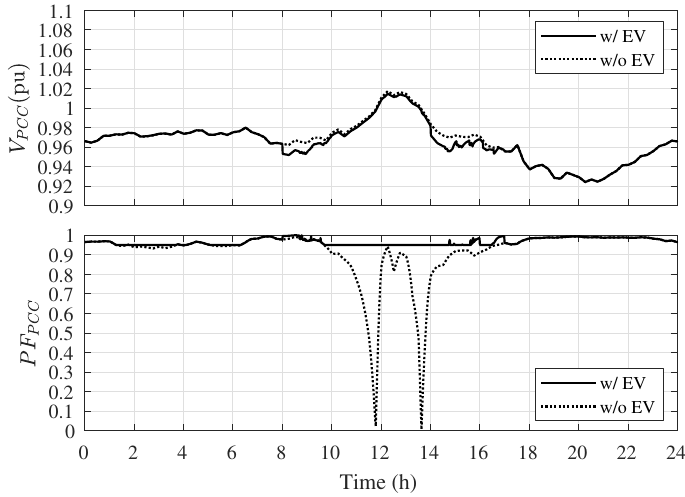
Figure 14. Power factor and voltage at the PCC of the proposed microgrid for scenario 3. The SOC of each vehicle with their respective active and reactive power references are presented in Figure 15, and it shows some changes compared with the previous scenarios.